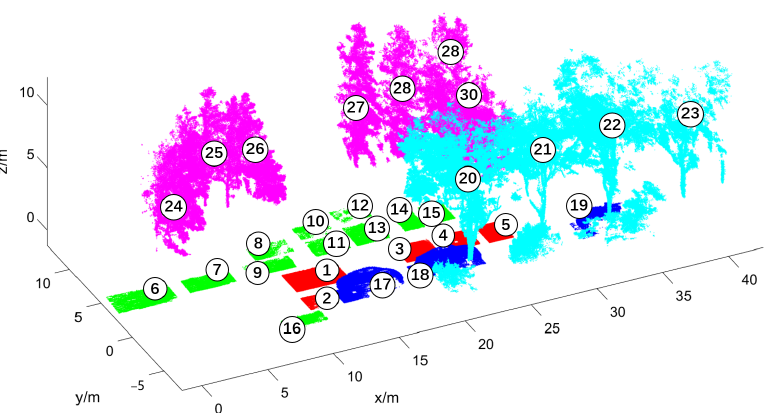
Figure 11. The selected areas of the outdoor environment used to calculate the mapping error. Several kinds of regions are selected and colored separately, with each type of region colored in the same color. Areas 1–5 are the ground, areas 6–16 are the flower bed, areas 17–19 are the cars, areas 20–23 are the tall trees, and areas 24–30 are the short trees. Table 5. The mapping error (MAE/m) comparison of the outdoor